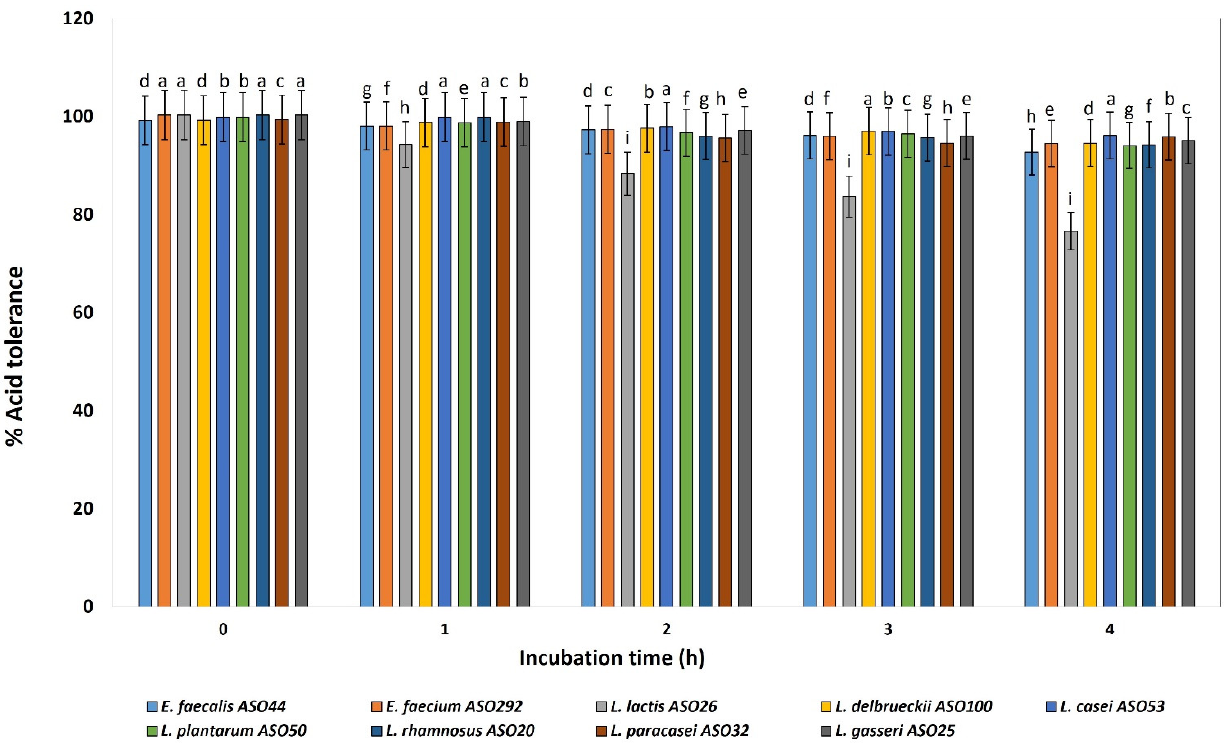
Figure 3. Percentage of acid tolerance of the isolated lactic acid bacteria during different incubation times of 0, 1, 2, 3 and 4 h. LAB isolates were grown on pH 3.0 for 4 h, and percentages of tolerance were estimated by counting viable bacterial counts which tolerated the acidic medium with relative to neutral pH conditions (pH 6.4). a–i Estimates with the same letters are not significantly different ( p > 0.05) among different isolates for the same incubation time.